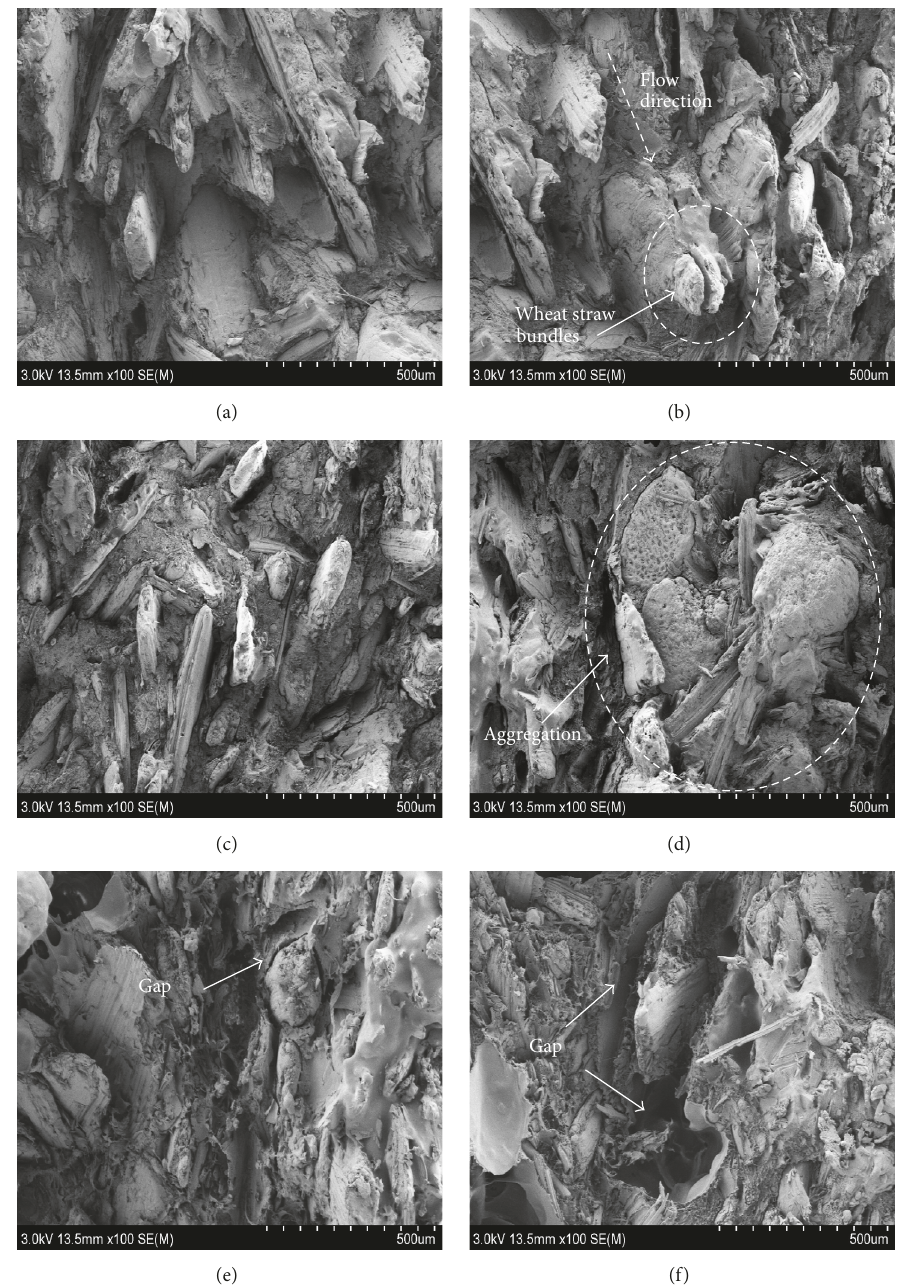
Figure 1: Morphology of fractured surfaces of WPCs: (a) VHDPE system with 10% PB dust, (b) 20% PB dust, (c) 30% PB dust, (d) 40% PB dust, (e) VHDPE/RHDPE system with 40% PB dust, and (f) RHDPE system with 40% PB